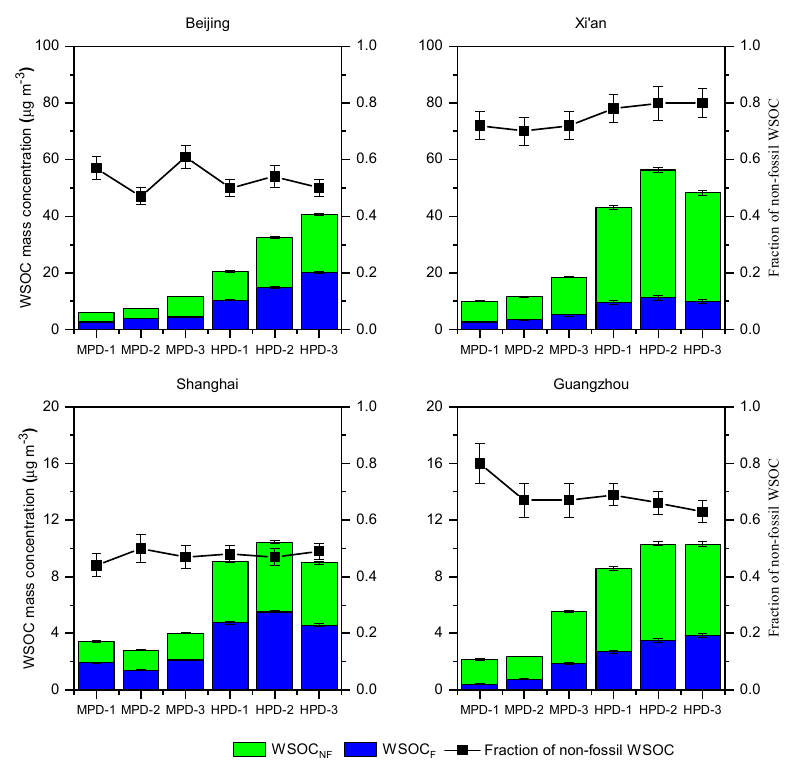
Figure 3. Mass concentrations (µgm 3 ) of WSOC from non-fossil and fossil fuel sources (WSOC NF and WSOC F , respectively) as well as non-fossil fractions of the WSOC aerosols from Beijing, Xi’an, Shanghai and Guangzhou during moderately polluted days (MPD) and heavily polluted days (HPD). Note the different scaling for different cities.